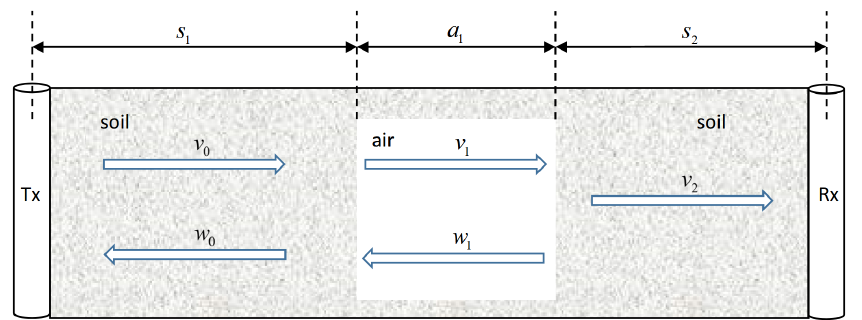
Figure 1. An EM wave propagates across a cavity between two boreholes. The wave is reflected at every